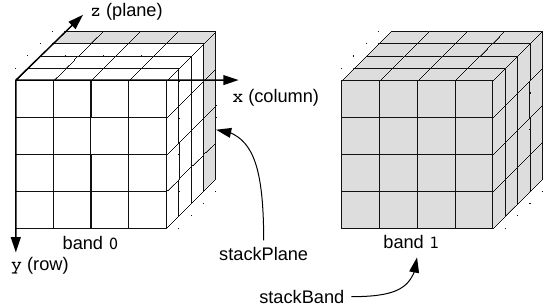
Figure 4. The pyjeo raster data model is a multi-band 3D dataset, represented by the Python class Jim . The function stackPlane adds a plane to the dataset, whereas stackBand adds a new band with the same dimension as the existing